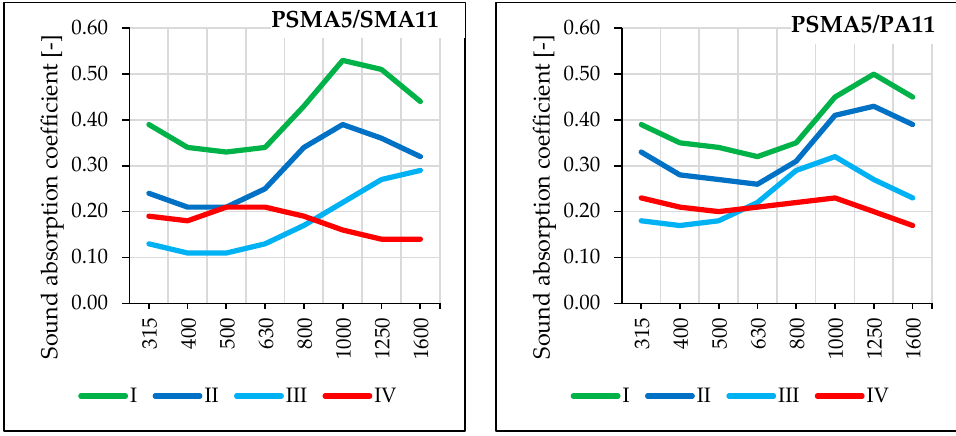
Figure 20. Comparison of sound absorption coefficient in the range of eight frequencies in four